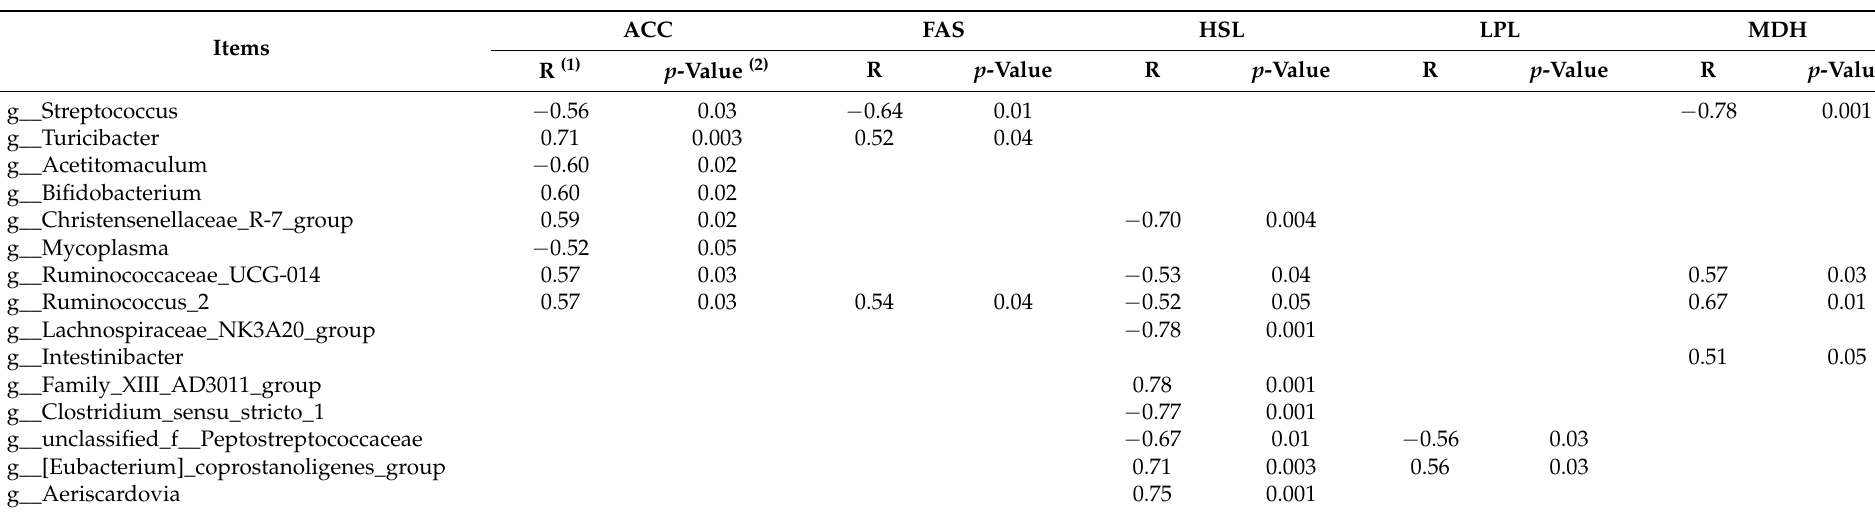
Table 12. The enzymes related to blood lipid metabolism showing a Spearman’s correlation with ileal bacterial community.